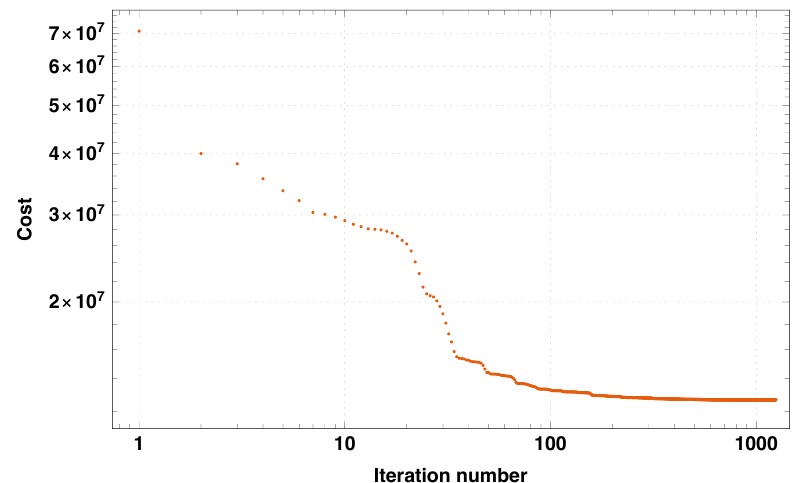
Figure 3. Minimisation of the cost function.